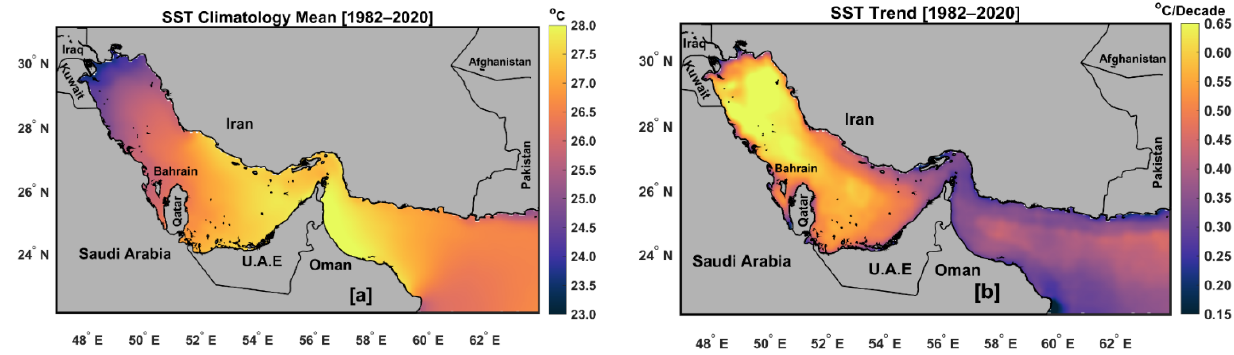
Figure 2. The spatial maps of mean SST in °C ( a ) and the trend of deseasonalized SST in °C/decade ( b ) from 1982 to 2020.